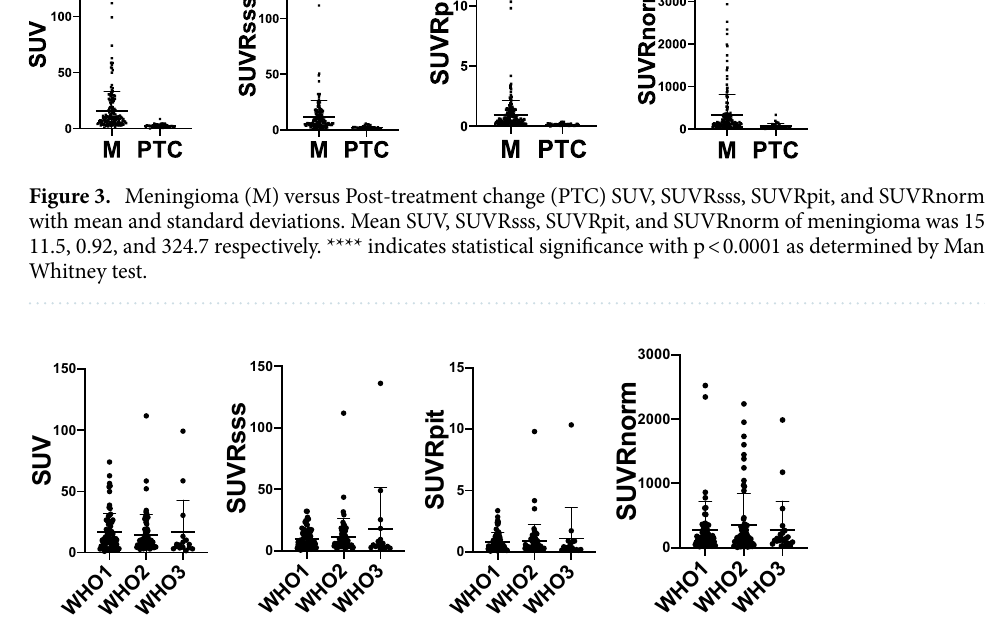
Figure 4. Meningioma SUV, SUVRsss, SUVRpit, and SUVRnorm stratified by WHO Grades with mean and standard deviations. Kruskal–Wallis test showed no statistically significant relationship between WHO Grade and the four SUV metrics.